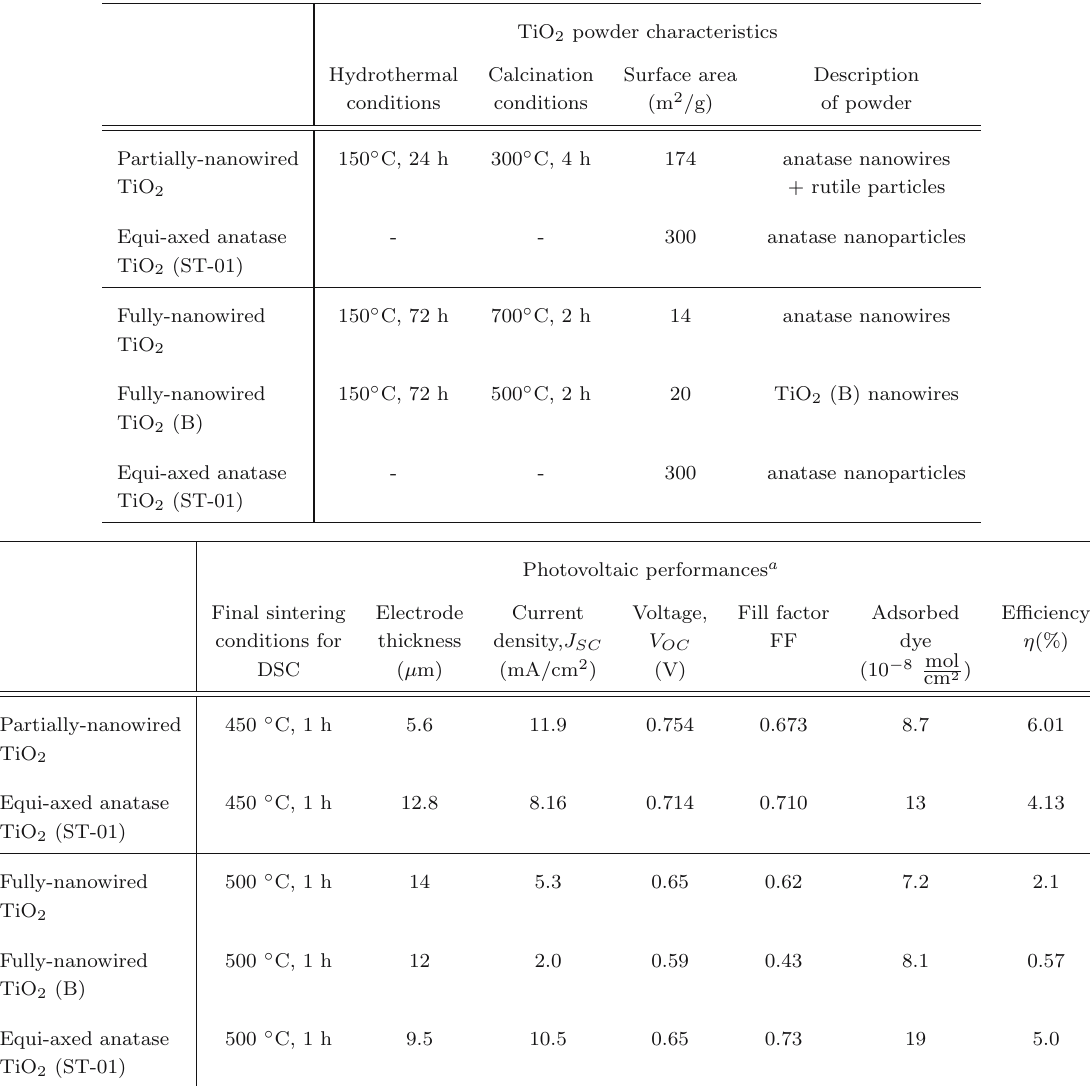
Table 1 TiO powder characteristics and photovoltaic performances obtained from the 2 I-V curves of the fabricated dye-sensitized solar